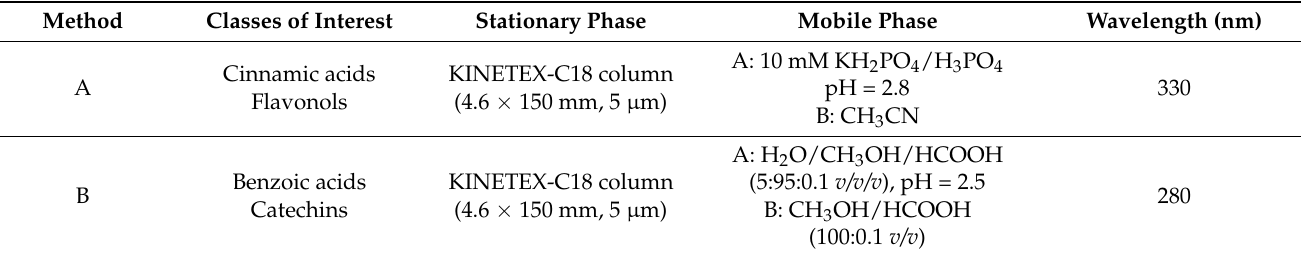
Table 1. HPLC methods and relative chromatographic conditions.